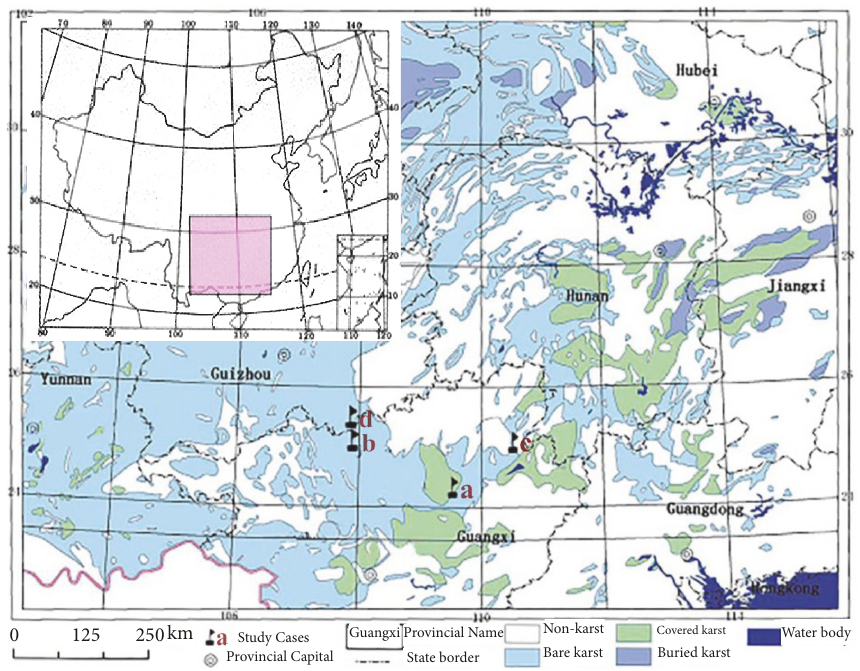
Figure 1: Location of the four studied rivers and the karst distribution in South